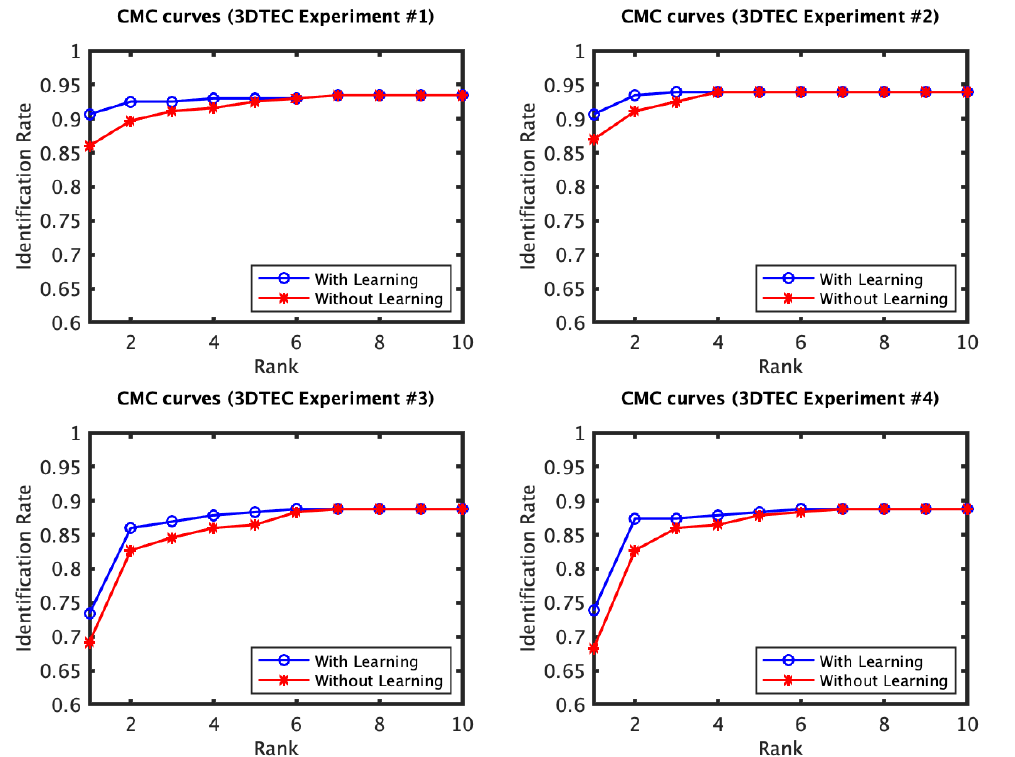
Figure 10. The CMC curves of the four 3D TEC experiments based on local 3D PCA descriptor.